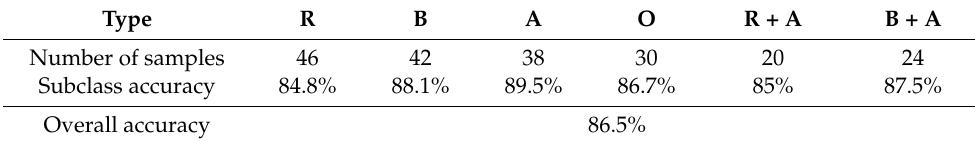
Figure 12. Color deviation histogram based on survey data measurement. Table 6. Building classification accuracy for the 200 sampled